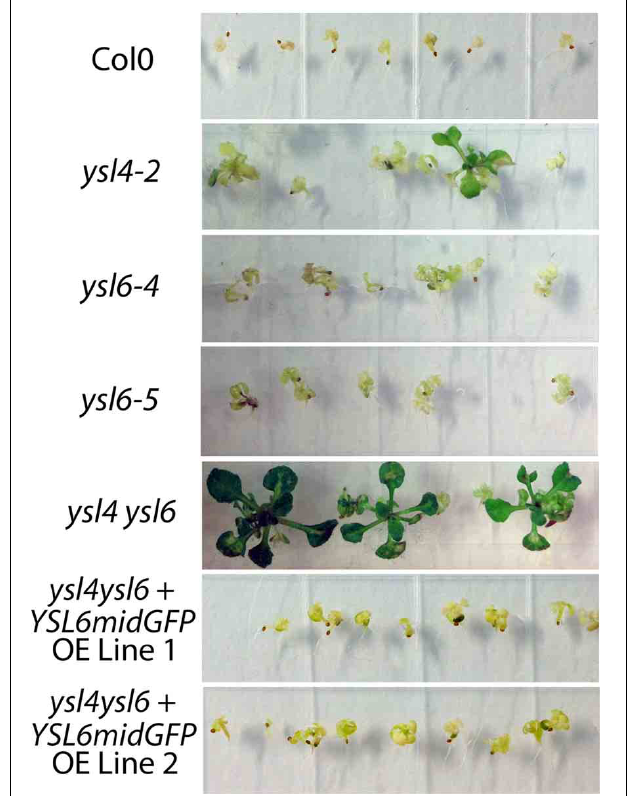
FIGURE 12 | Prolonged growth of mutants and YSL6-midGFP-OE complemented mutants on excess Mn. Seeds of Col0, ysl4-2 , ysl6-4 and ysl6-5 single mutants, ysl4ysl6 double mutants and two independentlines of ysl4ysl6 double mutants transformed with a construct over expressing the AtYSL6midGFPconstruct (YSL6midGFP) were sown onto 1/2X MS medium containing 1.0mM excess MnSO4 and grown for 35